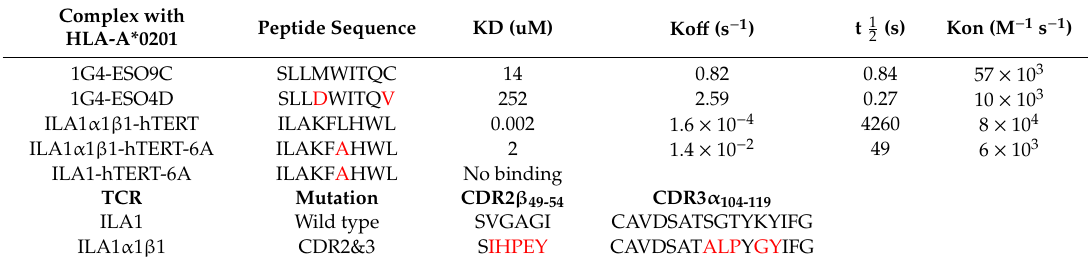
Table 1. The simulated complexes and the corresponding experimental binding a ffi nity data [41,42]. The MHC class I is the HLA-A*02:01. The last two lines report the sequence di ff erences between the ILA1 and the ILA1 α 1 β 1 (the mutated residues are reported in